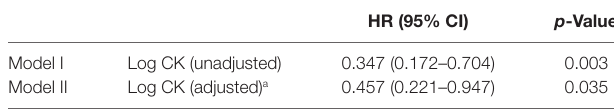
Table 3 | Cox proportional hazards survival analysis